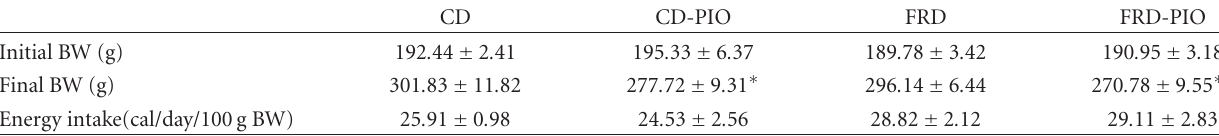
Table 1: Initial and final (on third week after diet/treatment) rat body weight (BW) and 21-day average of energy intake. CD CD-PIO FRD